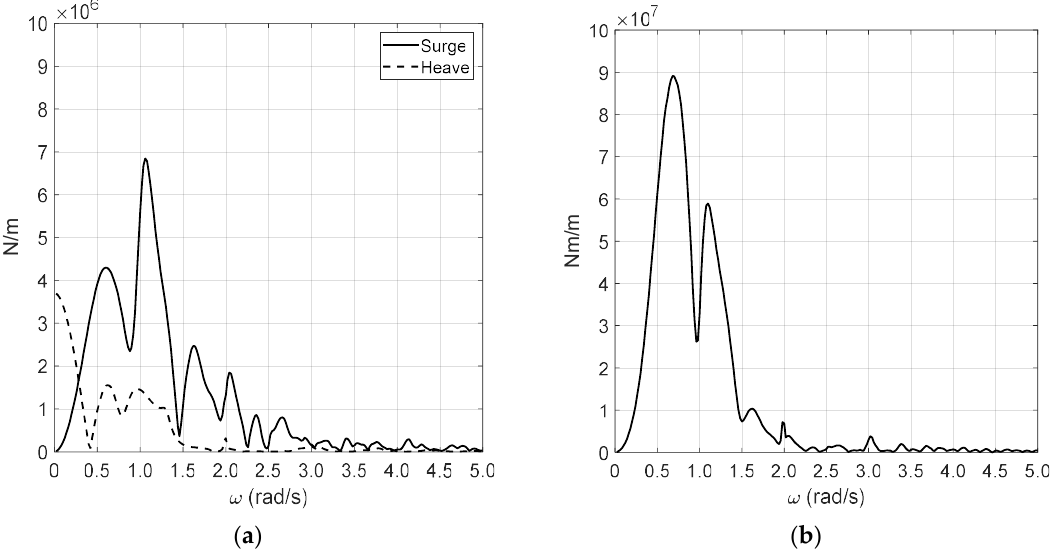
Figure A1. Absolute exciting forces per unit wave amplitude of the OC4-DeepCWind platform. ( a ) Surge/heave motion; ( b ) pitch